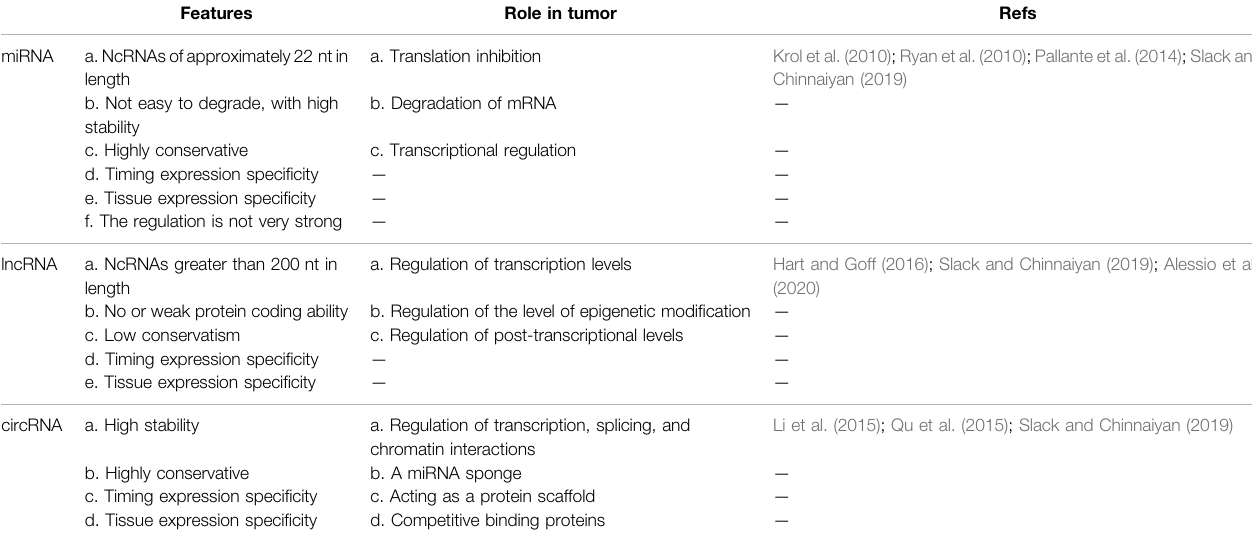
TABLE 2 | Comparison of features and role in tumor of miRNA, lncRNA and circRNA.